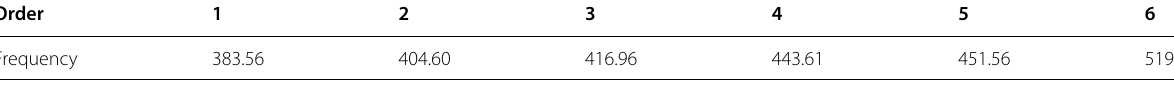
Table 4 The normalized frequencies of cylindrical shell with a random mistuned bolt distribution sample with σ θ Order 1 2